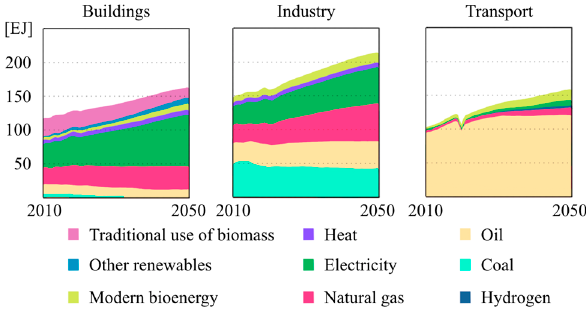
Figure 2. CO 2 emissions by sector, world [1]. Figure 3. Total final consumption by sector and fuel [2]. Figure 3. Total final consumption by sector and fuel [2].